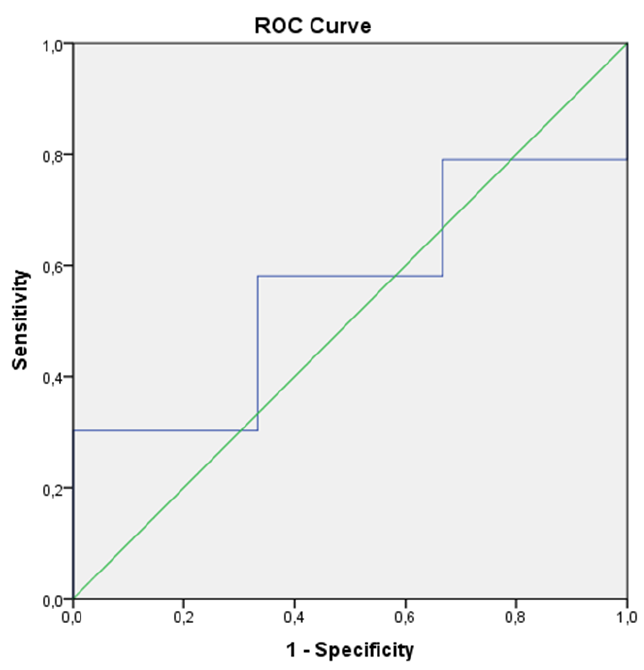
Figure 4. ROC curve in 2016 comparing the Jones and Beneish models. Source: own research.